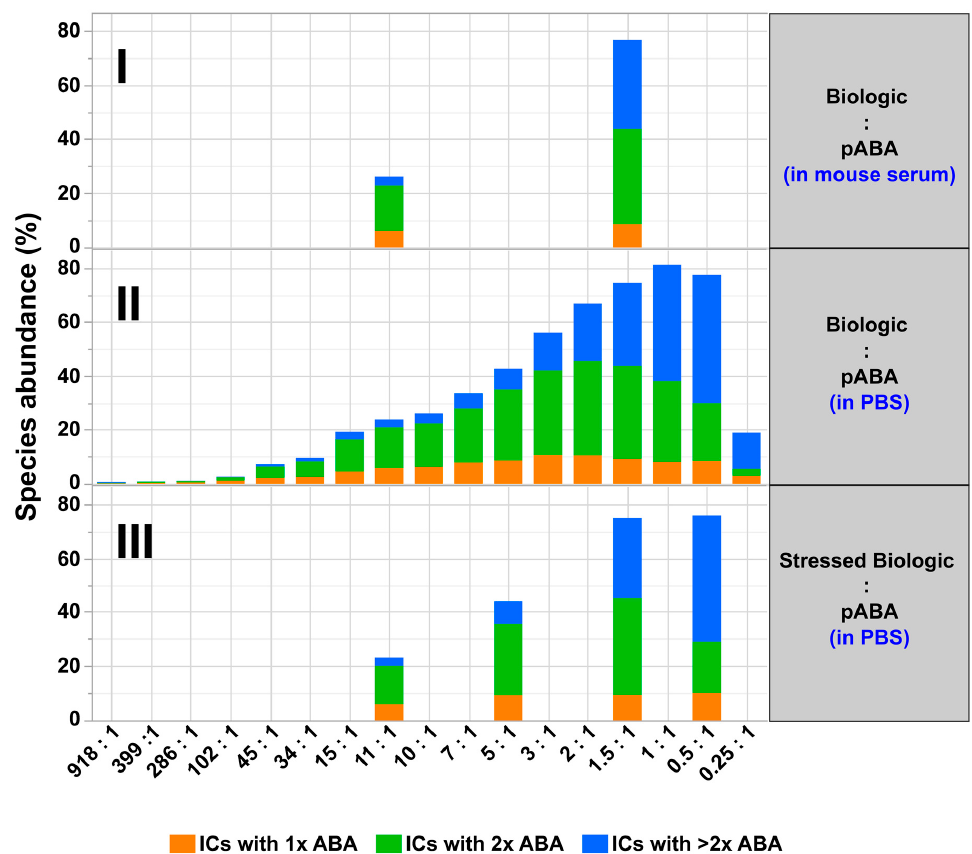
Figure 11. Quantitative SEC analysis read-out assessing relative levels of formed immune complexes between biologic and pABA. Analyzed mixtures are shown containing indicated molar ratios between biologic and pABA in diluted serum background on panel ( I ) and in PBS on panel ( II ). Quantified immune complex amounts using stressed biologic (4 weeks at 37 ◦ C in PBS) are shown on panel ( III ). Detected amounts of free components are not represented in the